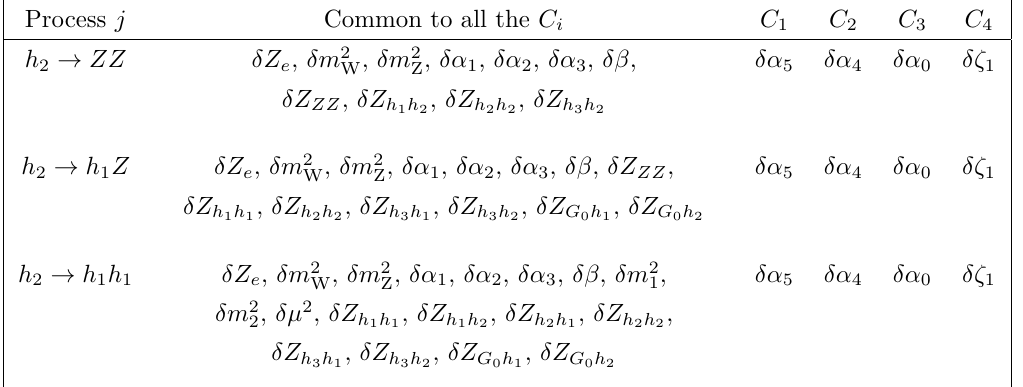
Table 3 . Total set of independent counterterms contributing to M CT